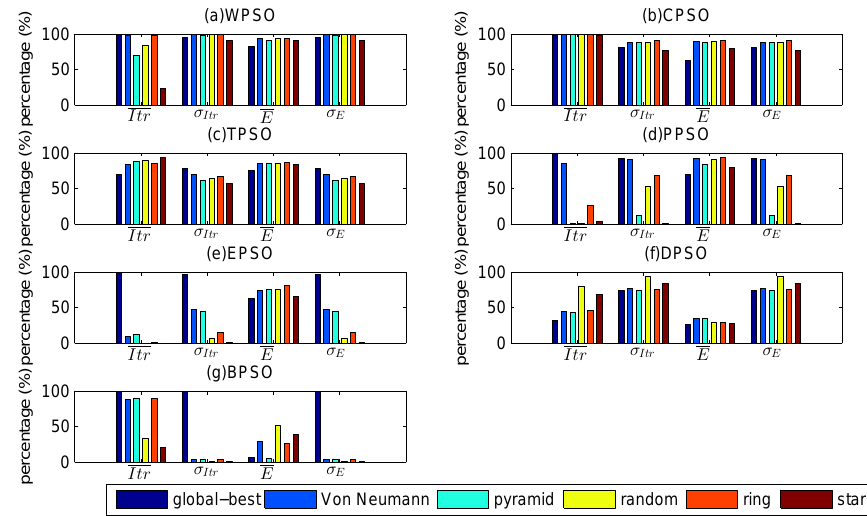
Figure 3. Percentage of each swarm topology achieving the optimal values. ( a ) WPSO; ( b ) CPSO; ( c ) TPSO; ( d ) PPSO; ( e ) EPSO; ( f ) DPSO; ( g ) BPSO.